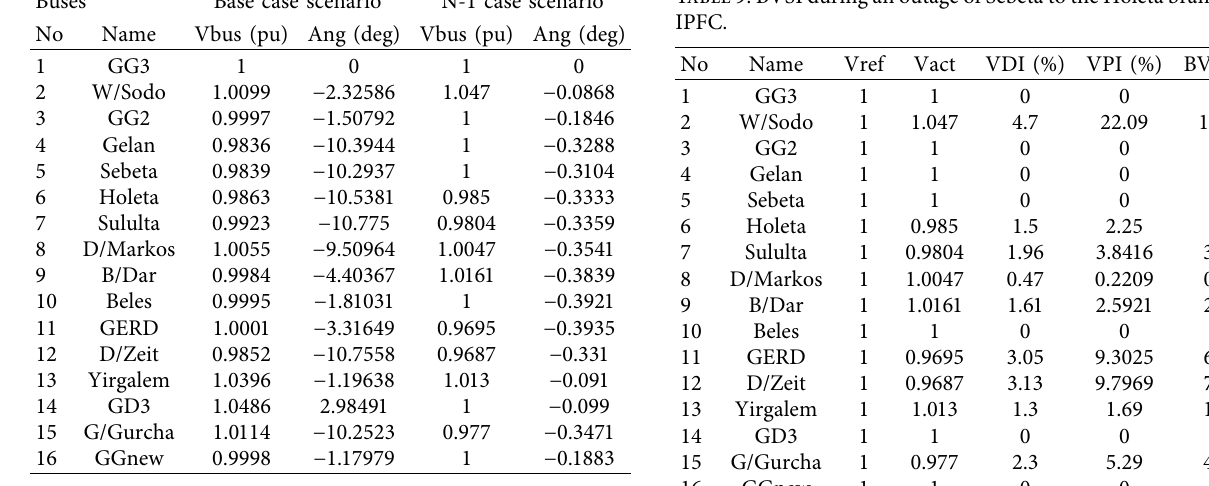
Table 8: Bus voltage magnitude and phase angle with IPFC.